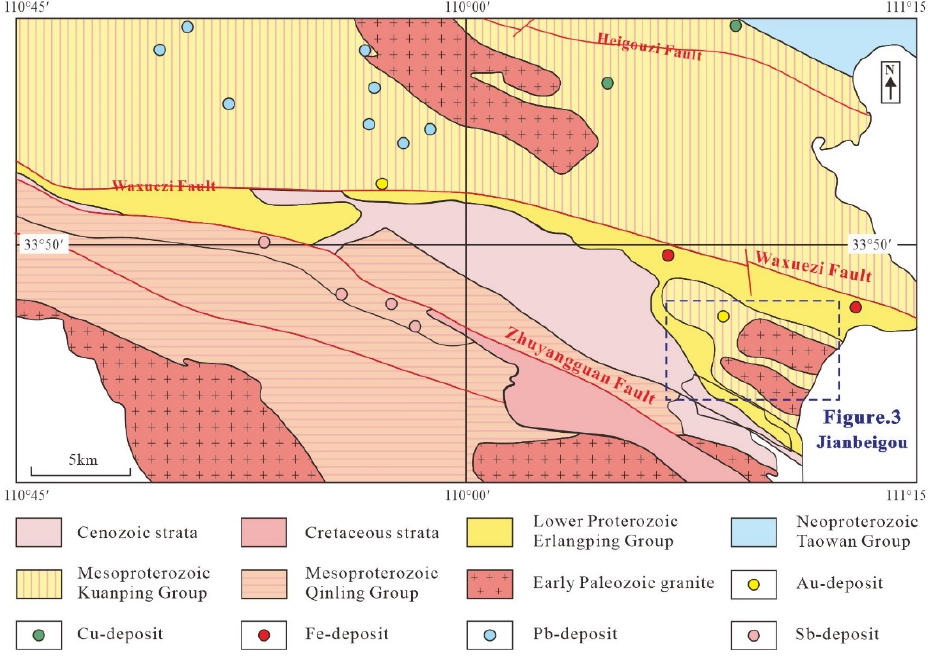
Figure 2. Geological map of Lushi gold polymetallic ore concentration area and distribution of metal deposits (Modified form [40]).